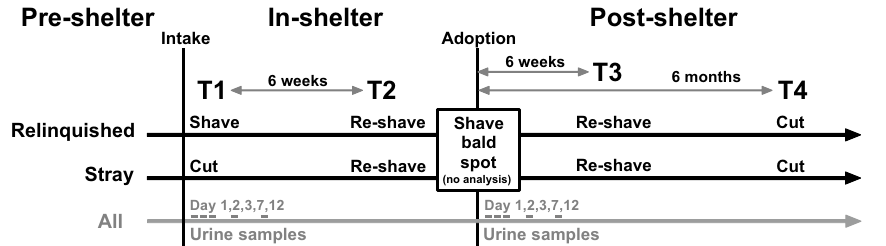
Figure 1. Timeline of shelter dog hair and urine sample collection moments: after intake (T1), after 6 weeks in the shelter (T2), 6 weeks after adoption (T3) and 6 months after adoption (T4). Stray dogs were cut instead of shaved at intake to prevent that a large bald spot was visible if dogs would be recollected by their